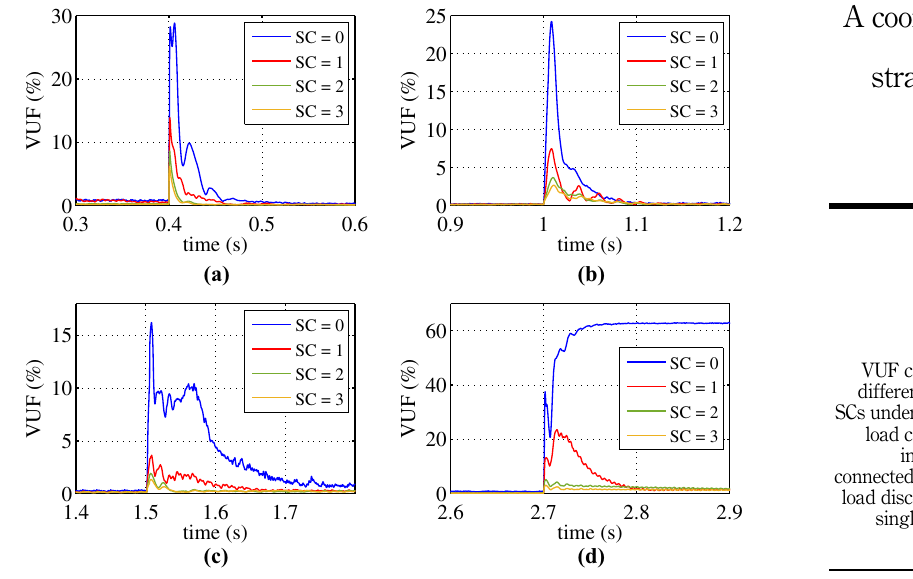
Figure 7. VUF compare with different number of SCs under (a) resistive load connected, (b) inductive load connected, (c) resistive load disconnected,